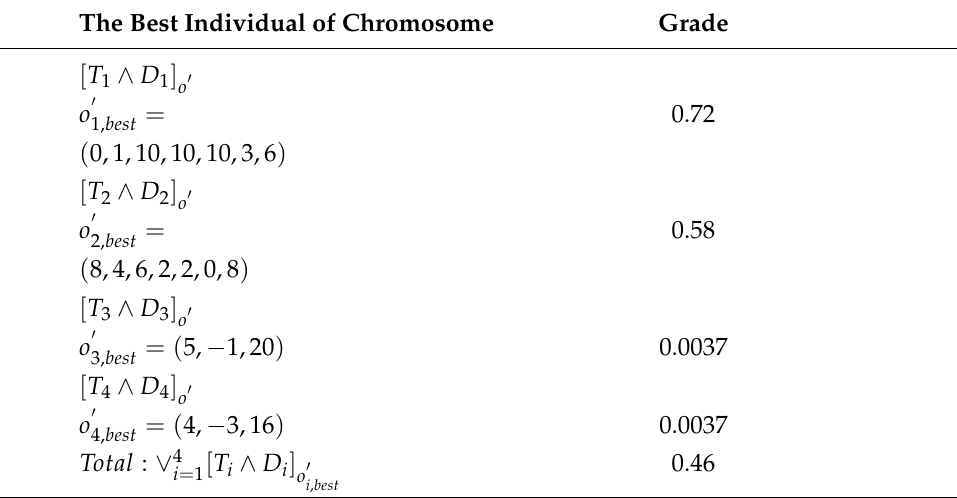
Table 5. Results for process gcd after applying